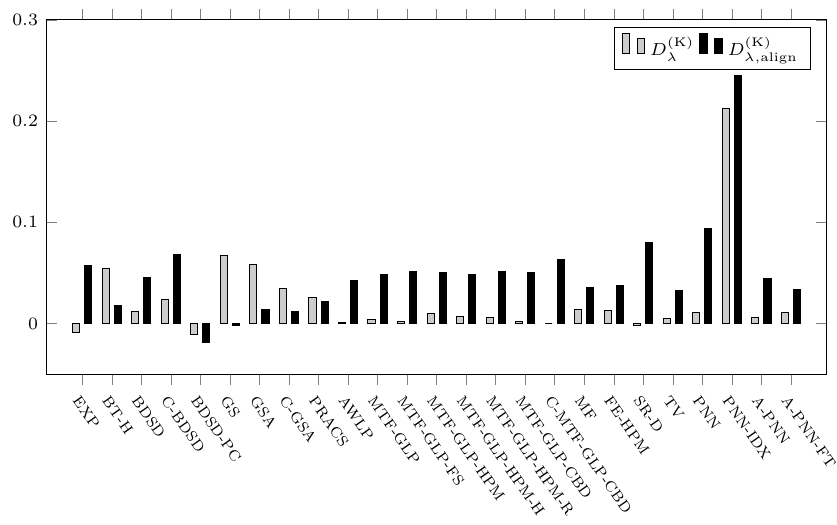
Figure 3. Misregistration impact on D ( K ) due to data